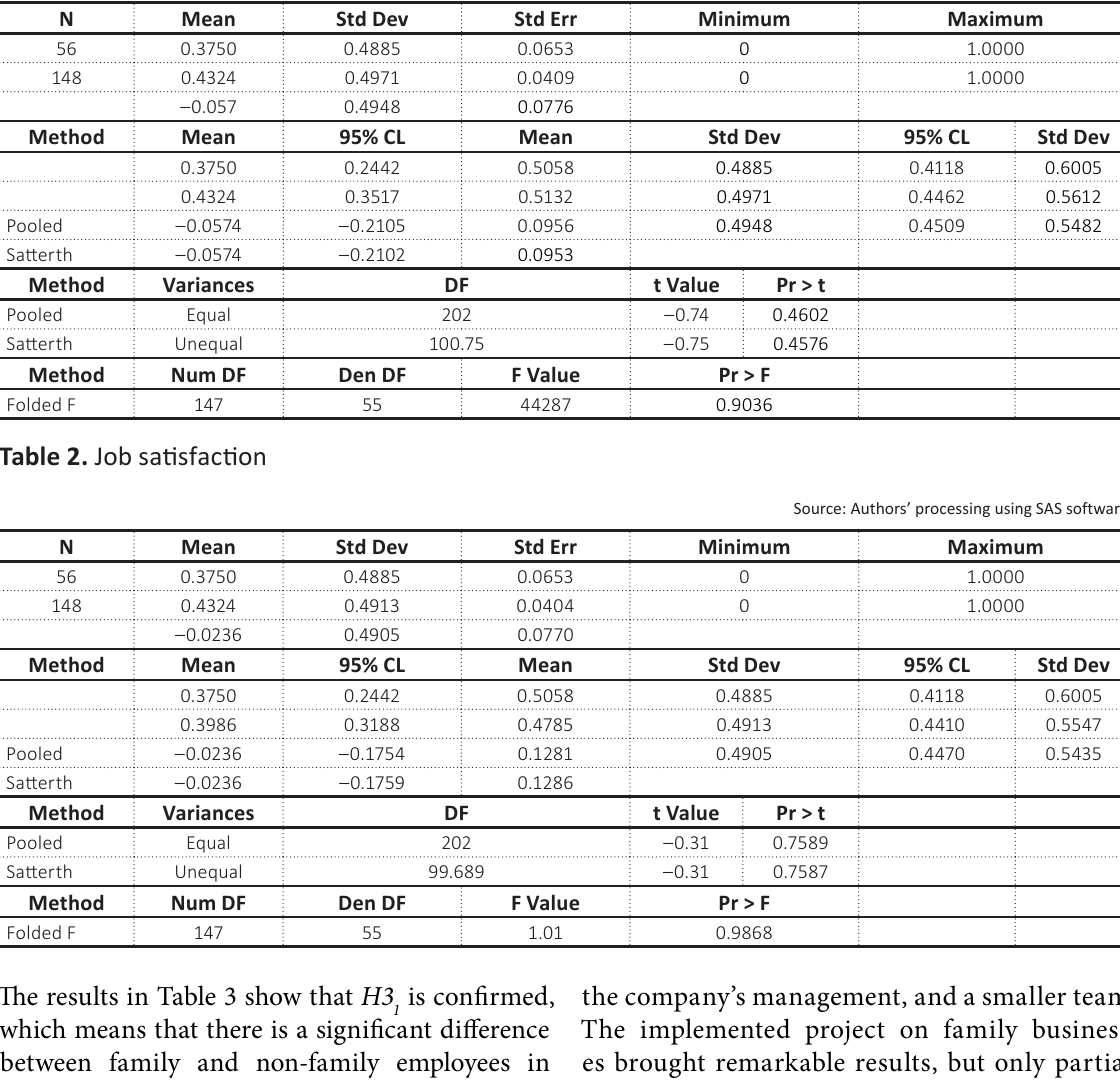
Source: Authors’ processing using SAS software.